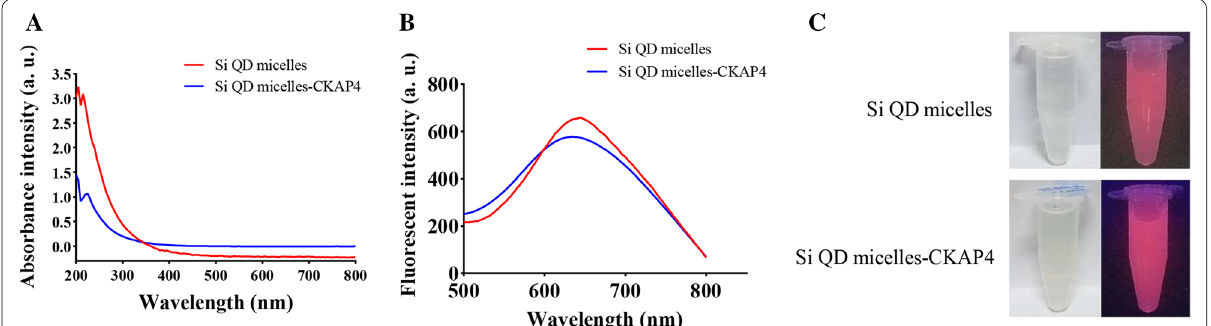
Fig. 2 a UV–visible absorption spectrum of Si QD micelles and Si QD micelles-CKAP4; b fluorescent emission spectrum of Si QD micelles and Si QD micelles-CKAP4; c images of Si QD micelles and Si QD micelles-CKAP4 exposed in natural light (left) and 365 nm UV light